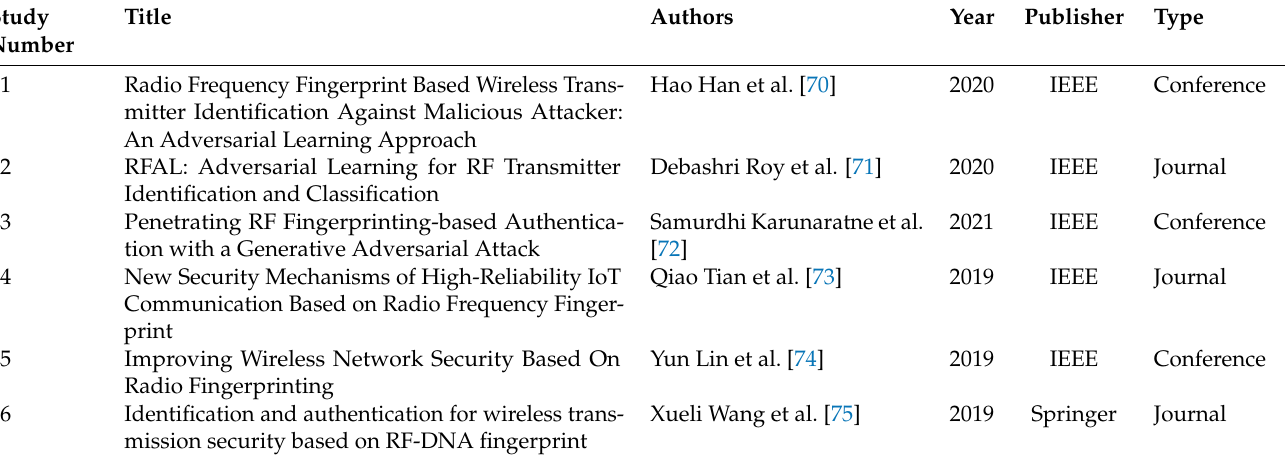
Table 4. Studies that met the quality evaluation